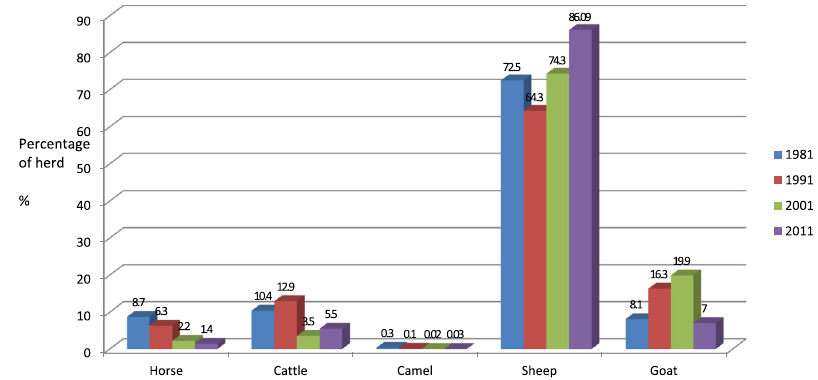
Fig. 1 Percentage composition of “ five key livestock ” in East Ujimqin Banner (Source: Calculated and compiled based on data obtained by Dongwu Qi Statistics Bureau and Local Records Office,